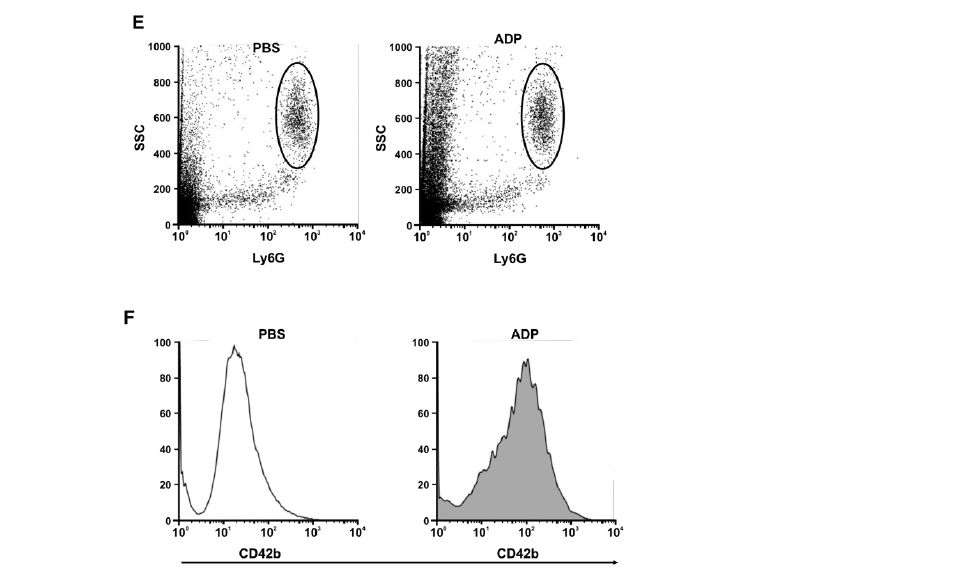
Figure A5. Gating strategies and MFI for cytometry analysis shown in Figure 5. ( A – C ) Human PRP or whole blood was treated with either PBS or ADP. ( D – F ) Murine PRP or whole blood was treated with either PBS or ADP. ( A ) Representative histograms showing GPIIb/IIIa activity using PAC-1 antibodies. ( B ) Platelets were gated according to SSC and FSC. ( C ) Mean fluorescence intensity (MFI) of JON/A. ( D ) Representative histograms showing GPIIb/IIIa activity using specific JON/A antibodies. ( E ) Neutrophils were gated according to SSC and Ly6G. ( F ) Representative histograms showing CD42b MFI of platelets on neutrophils. n ≥ 3; unpaired Student’s t -test with *** for p < 0.001.